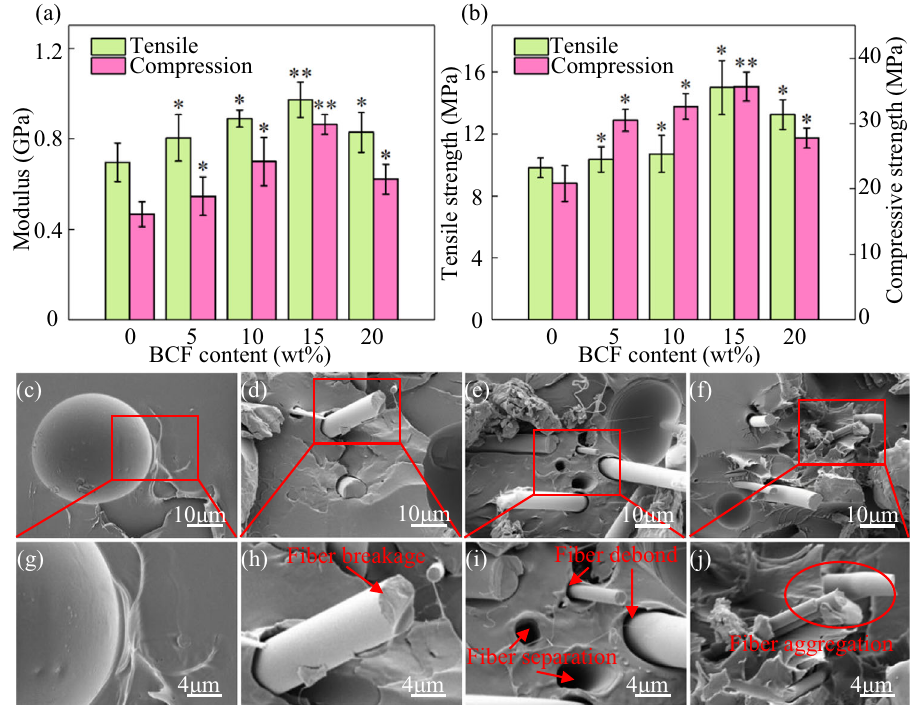
Fig. 5 Mechanical properties of the scaffolds. a Mechanical modulus and ( b ) mechanical strength of scaffolds with different BCF contents, ( c, g ) fracture morphology of the neat group, d, h fi ber breakage, ( e, i ) fi ber debond and separation occurred in the fracture of the PLLA/15BCF group and ( f , j ) fi ber aggregation occurred in the fracture of the PLLA/20BCF group. * was evaluated via the t-test and indicated the statistical difference (* p < 0.05, * *p < 0.01) between the composite scaffolds containing various BCF and the pure PLLA scaffold. The error bars represent the standard deviations from four independent